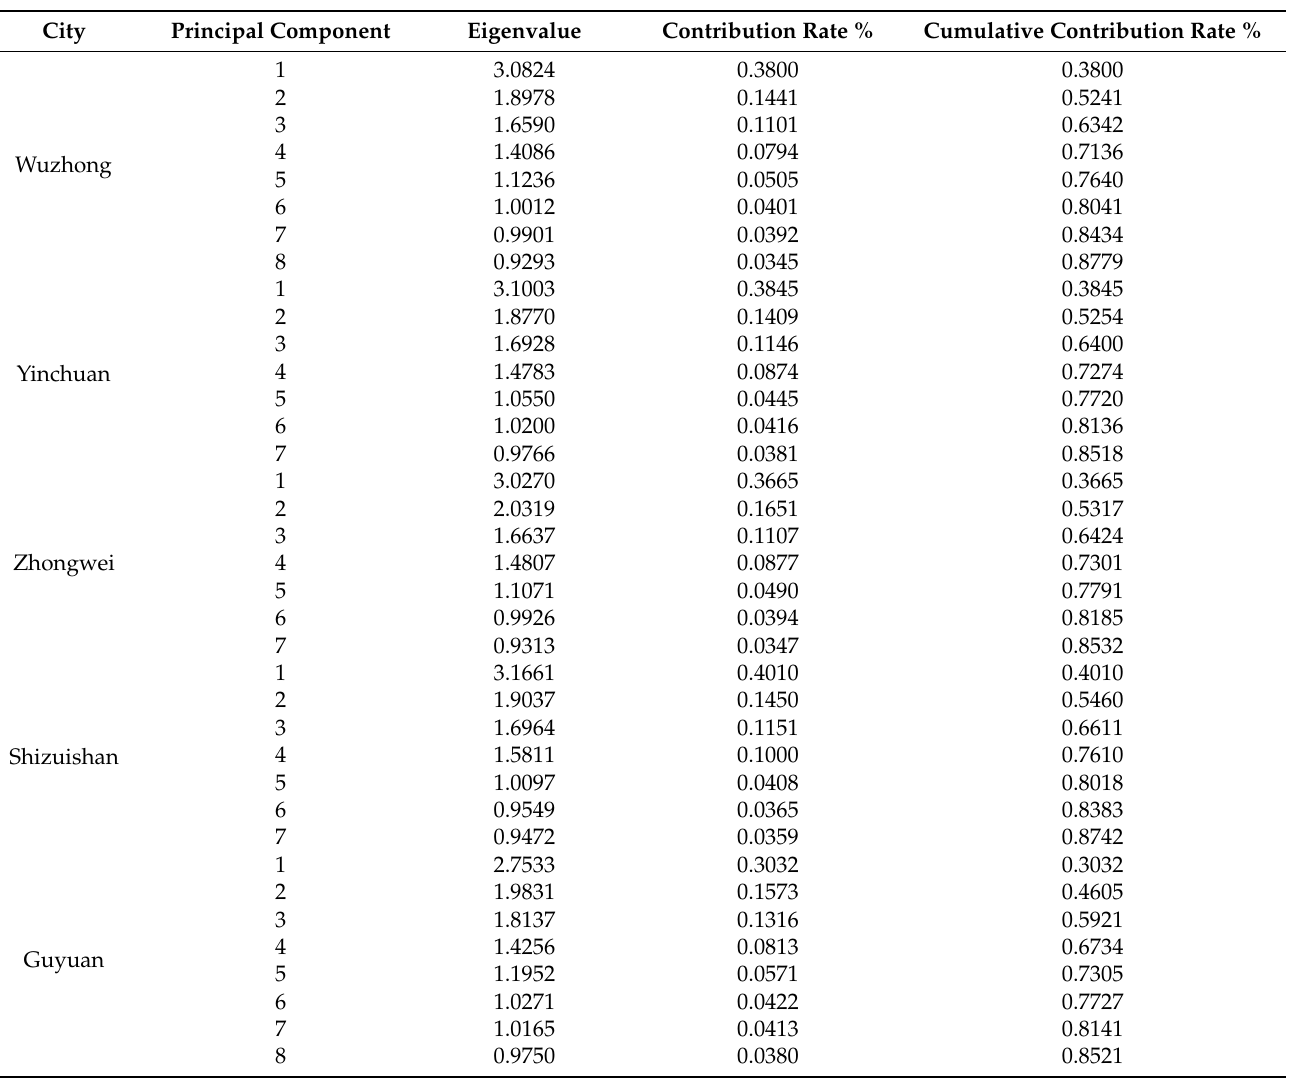
Table 3. Principal component analysis.